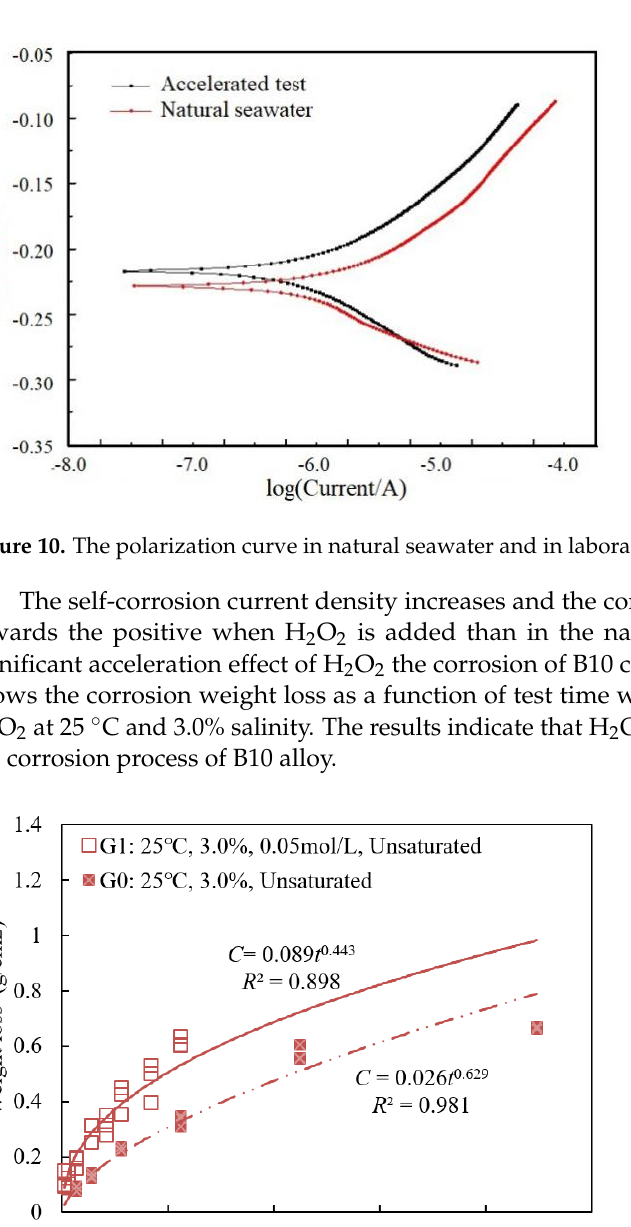
Figure 11. Metal weight loss as a function of test time with and without H 2 O 2 .